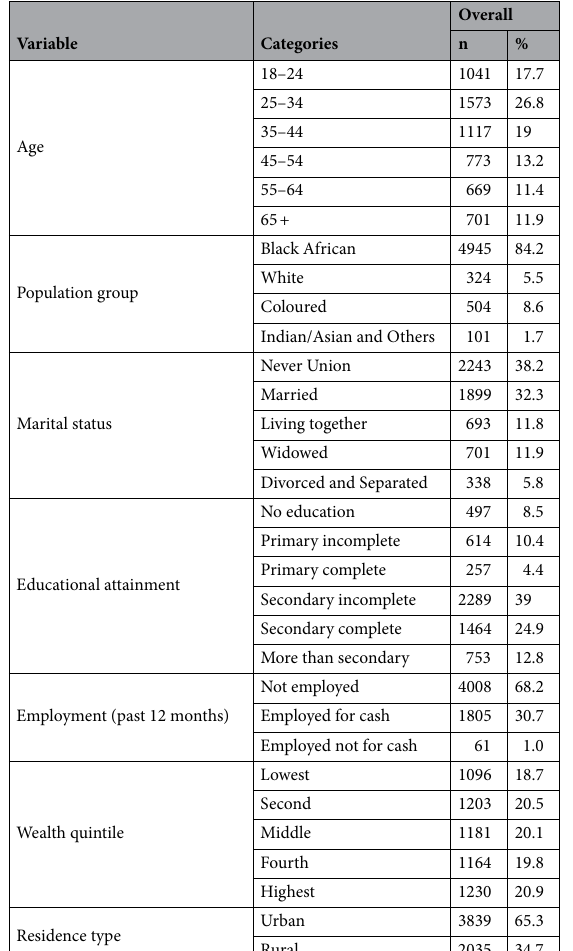
Table 1. Sociodemographic of study participants (N = 5,874). Although the sample size of the Domestic Violence Module indicated in the previous SA-DHS report produced by the South African National Department of Health is 5,865, we report our estimate based on 5874 (weighted) ever-partnered women from the Domestic Violence Module. The main DHS acknowledges the nine cases differential in the SA-DHS report, with the difference after our own reproduction being